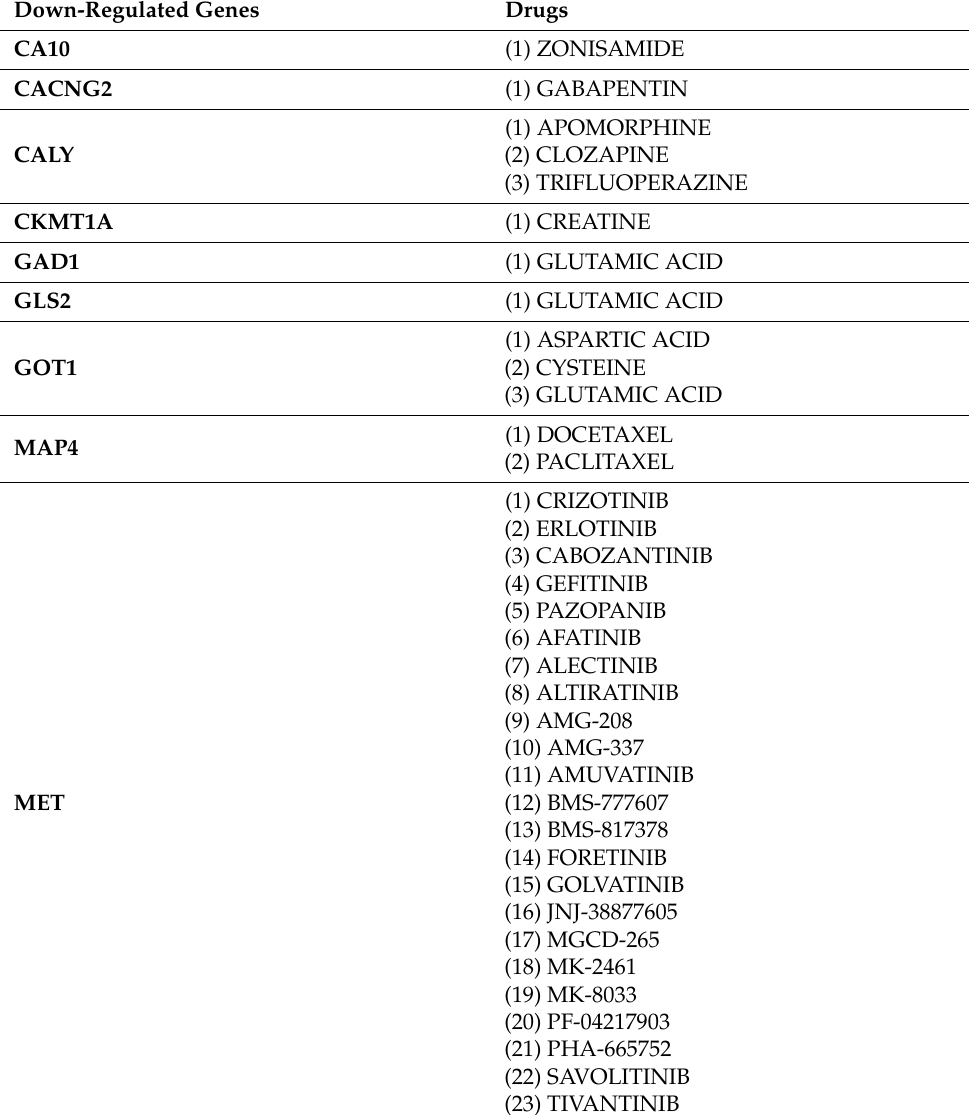
Table 1. Down-regulated genes and their interactions with known drugs in at least two of three drug databases (DGIdb, DrugCentral, and The Drug Repurposing Hub).